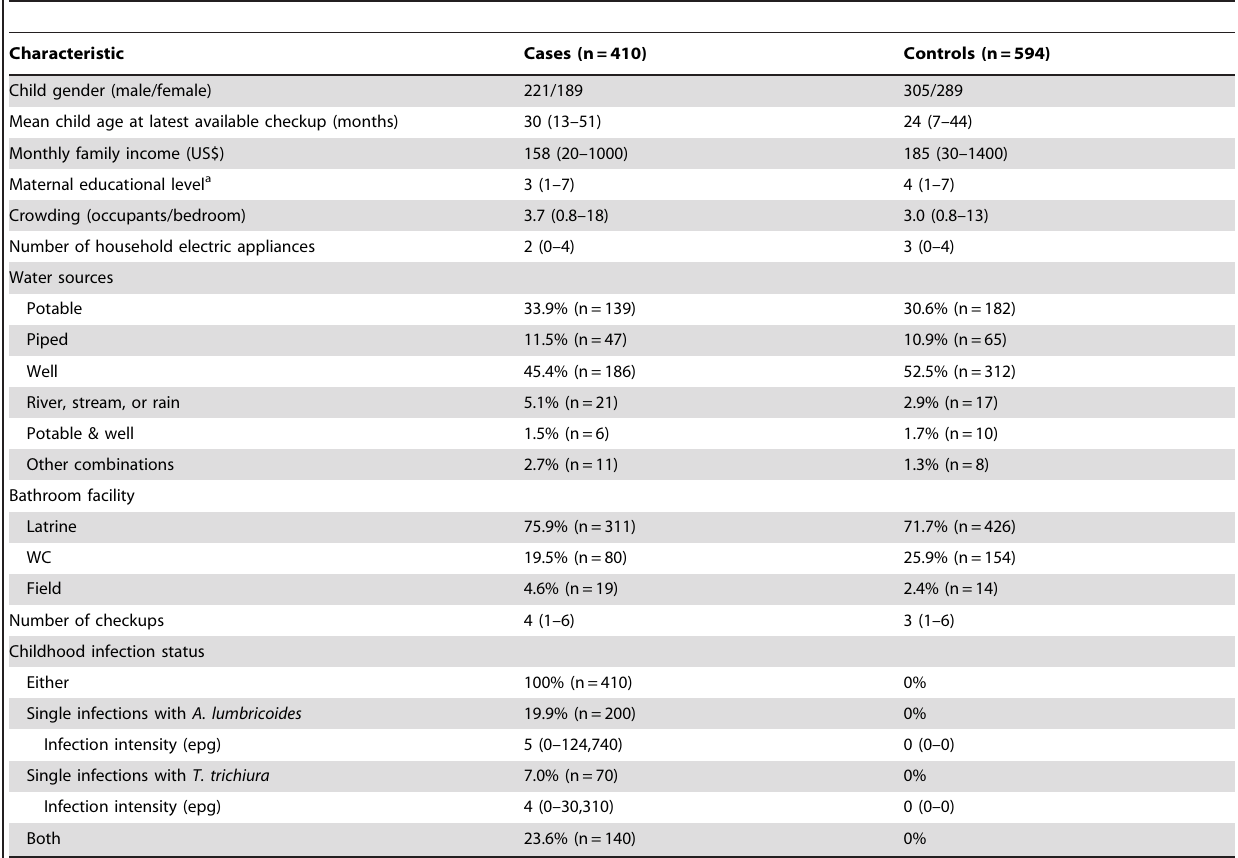
Table 1. Characteristics of cases and